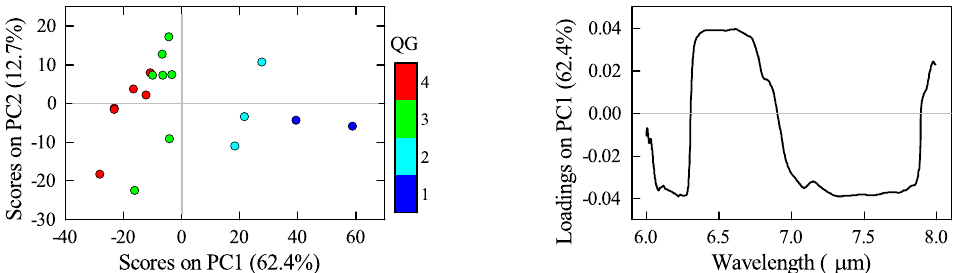
Figure 7. Principal component analysis (PC1 vs. PC2) of diatomite ores ( left ) and corresponding loadings plot ( right